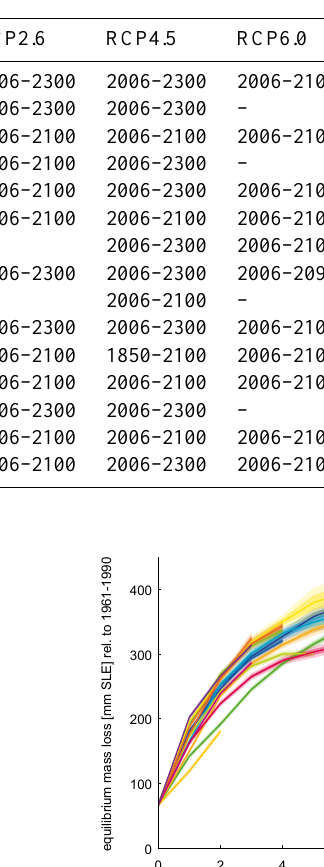
Table 1. CMIP5 models and experiments used for forcing.